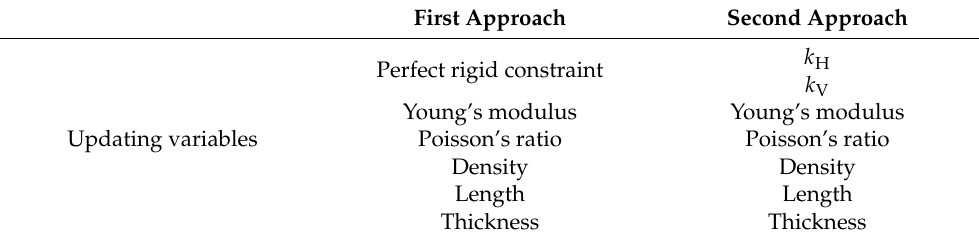
Table 5. Updating variables for the different model-updating approaches.